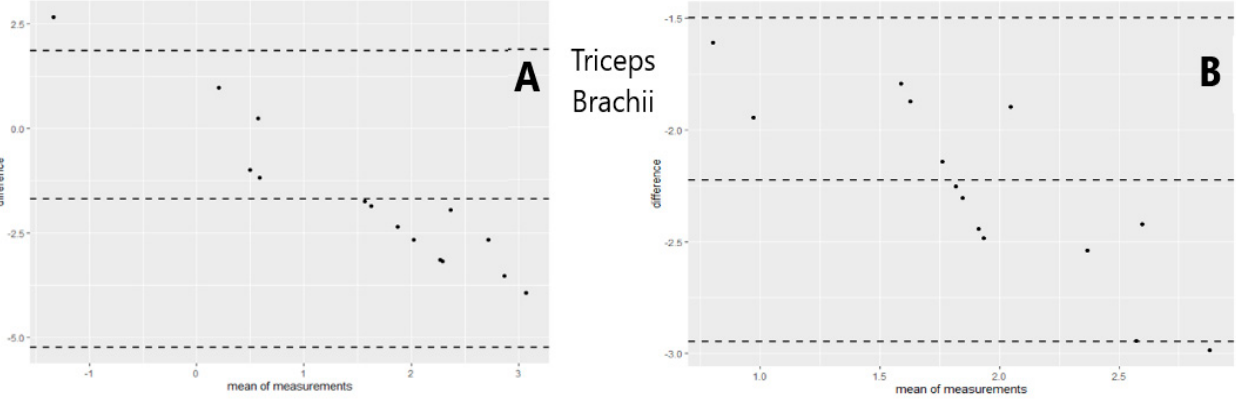
Figure 7. Differences between MRC scale and sEMG ( A ) as well as MRC and Dynamometry ( B ) for Triceps Brachii muscle versus the mean of the two measurements. The central line represents the mean difference (bias A = − 1.60; B = − 2.22), while the top and bottom lines represent the relative 95% CI (A = − 5.23; 1.85) (B = − 2.95; − 1.49). The Bland–Altman plots highlight the differences of measurements performed with the two instruments. When the points (representing the observations) are scattered within the CI, the instruments can be used interchangeably. This mean that there are no significant differences between the measurements obtained from both